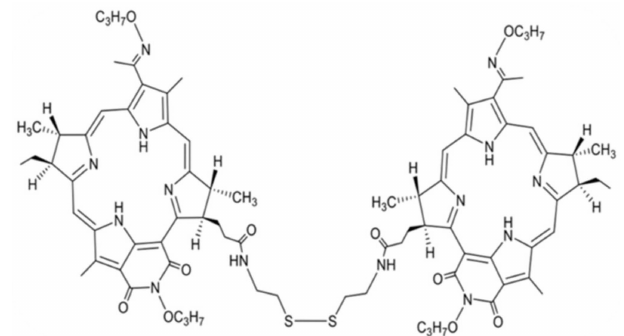
Figure 1. Structural formula of the photosensitizer conjugate of chlorin e 6 with a